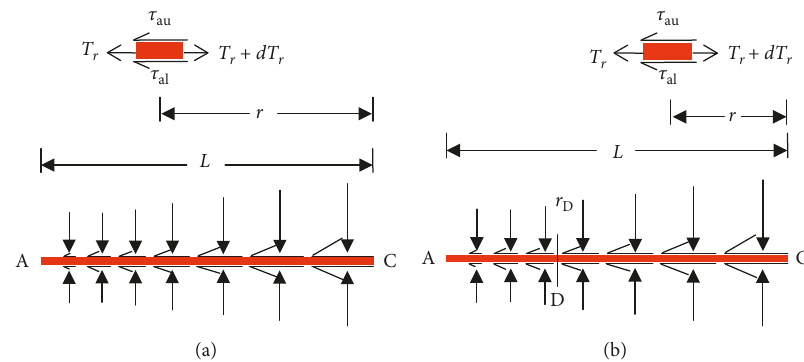
Figure 8: Analysis of the geosynthetic anchorage section: (a) does not reach critical relative displacement; (b) partially in critical dis- placement condition.